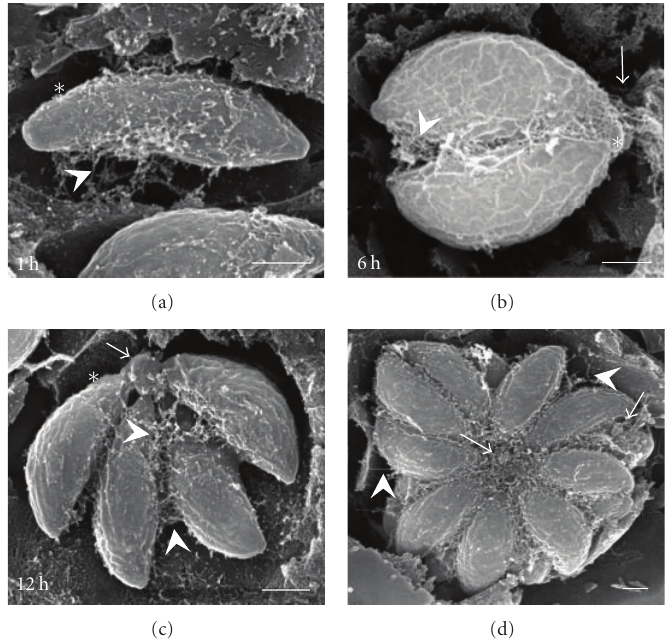
Figure 4: SEM-Tanaka sequence of intravacuolar proliferation of tachyzoites. Arrowheads indicate extensions of the MNN, which connect the incurved face of a single parasite to the PVM (1h), the incurved faces of parasites after the first and second divisions (6, 12h), or which connect the rosette to the PVM (24h). Arrows point out the RB (6–24h). Asterisks indicate the apparent empty space at the PV periphery (1–24h). Timing indicated in lower left corners represents the replication time after invasion. Bars = 1 µ